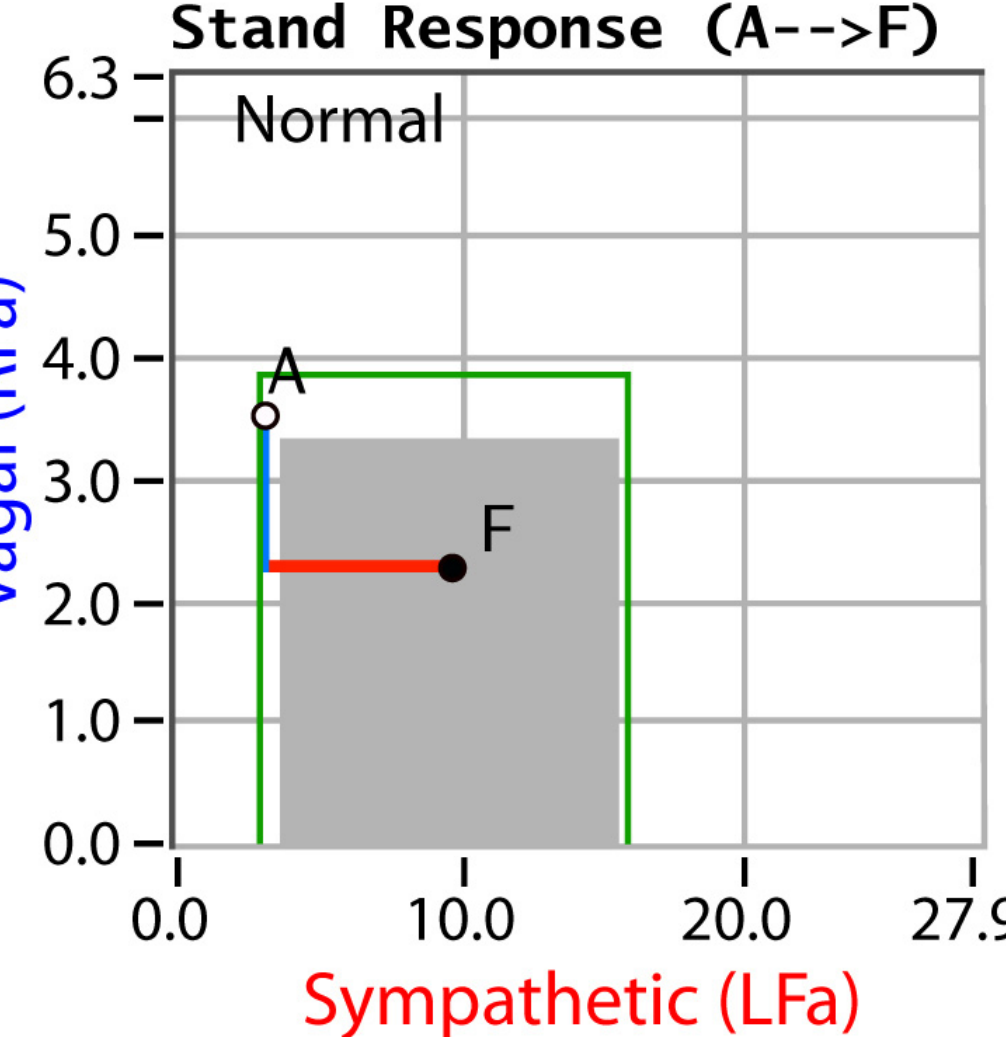
Figure 4. “Normal Response to Stand or Head-Up Postural Change.” The stand challenge response provides information regarding causes of lightheadedness (e.g., orthostatic dysfunction as associated with and abnormally low sympathetic response, or syncope as associated with an abnormally high parasympathetic response), as well as an indication of the ability of the two autonomic branches to coordinate responses, not only to postural change but in the control and coordination of organs and organ systems [16]. The figure displays a stand response plot demonstrating a normal Parasympathetic (a decreased response from rest, ‘A’, to stand, ‘F’) with a normal Sympathetic response (an increased response from rest, ‘A’, to stand, ‘F’). The gray area indicates the normal region. These data are baseline-adjusted. The area between the green lines and the gray indicates borderline normal responses. The symptoms associated with abnormal stand responses are often the first symptoms recognized as the results of autonomic dysfunction